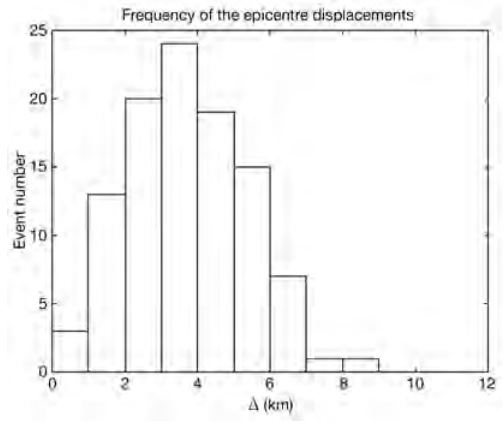
Fig. 4. Histogram of the event frequency with re- spect to the epicentre displacements as obtained using separately temporary and permanent network